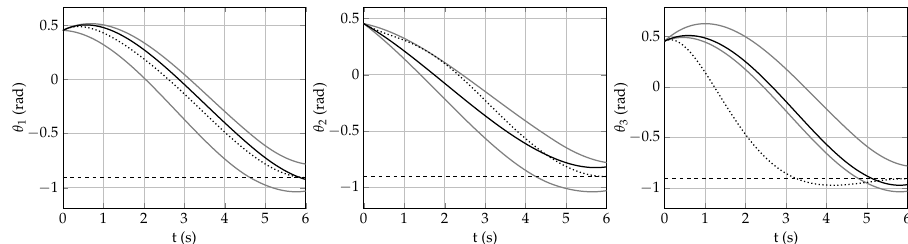
Figure 6. Attitude of the spacecraft. The black curves are the attitude of the actual nonlinear system, whereas the gray curves are the attitudes of the auxiliary linear system. The dashed line is the desired final attitude and the dotted line a solution using a non-convex solver.